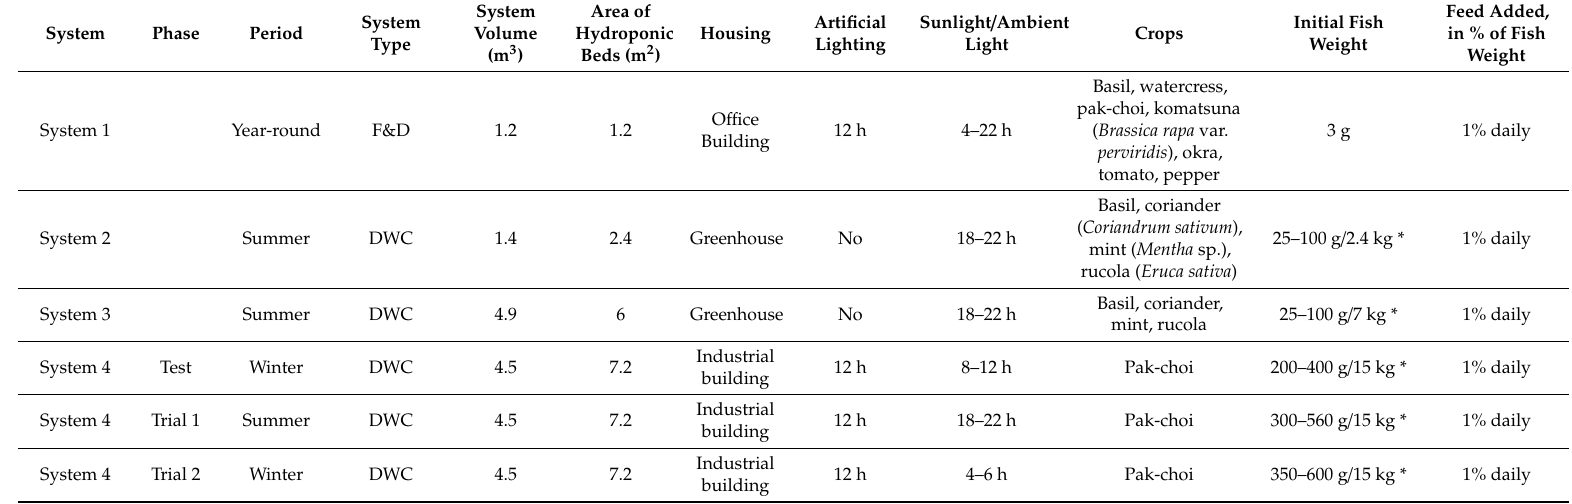
Table 2. Description of the design and implementation conditions of Systems